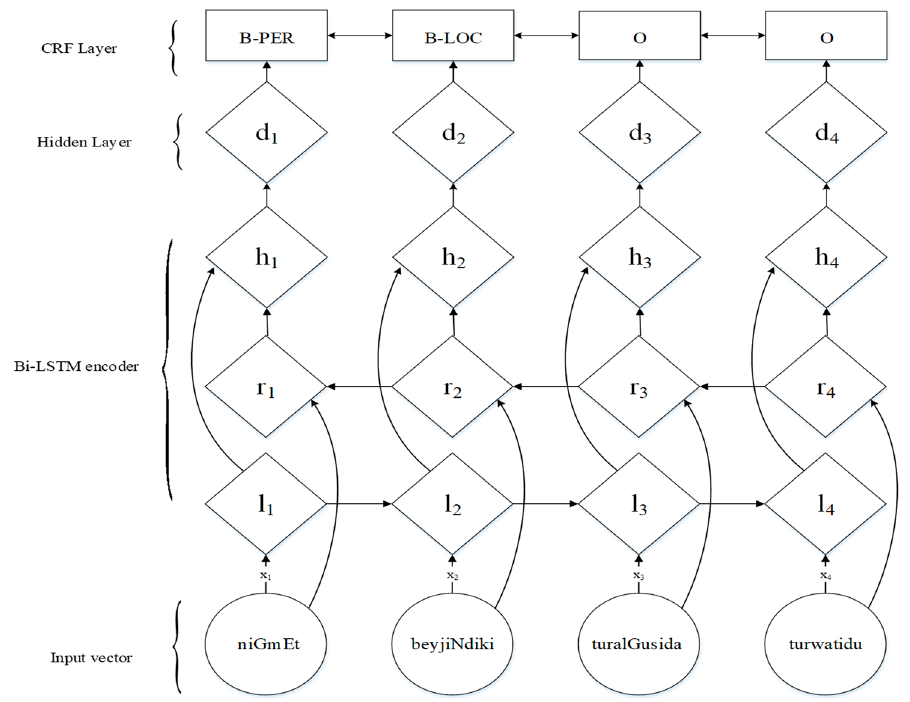
Figure 1. Word-based neural model.